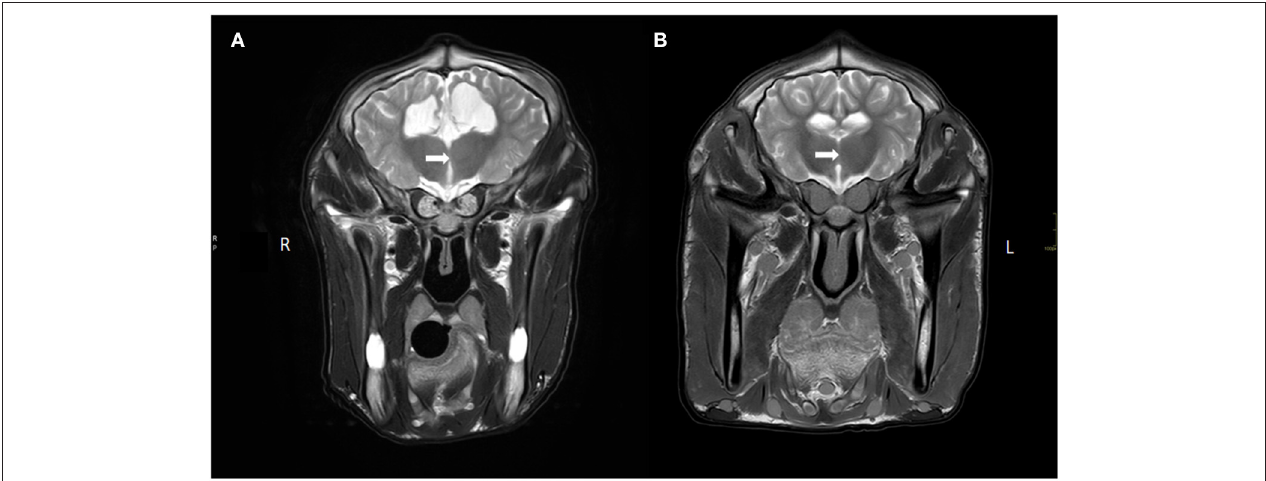
FIGURE 2 | Transverse T2W images of the brain at the level of interthalamic adhesion of (A) our current case with a hypoplastic/absent interthalamic adhesion (white arrow) in comparison with the interthalamic adhesion in (B) of a calf without brain lesions (at 7 months of age). Also note the ventriculomegaly and thin white matter tracts (corona radiata), thin cortex and increased CSF signal ventral to the thalamus in (A) compared to (B)